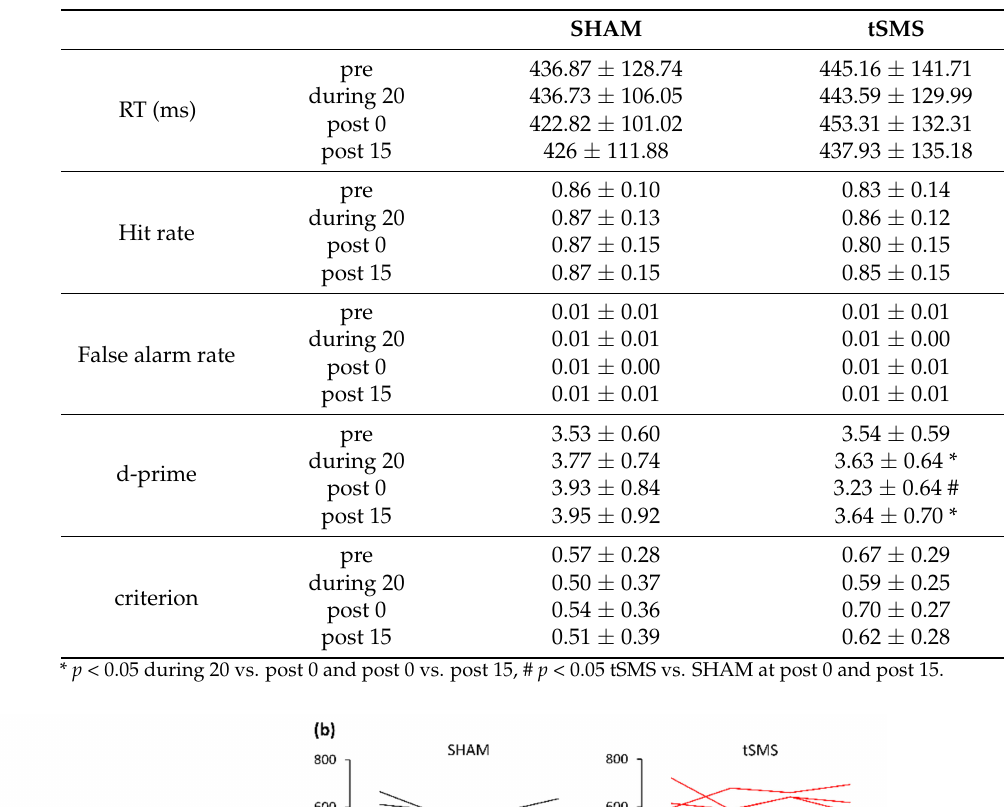
Table 1. Reaction time (RT), hit rate, false alarm rate, d-prime, and criterion (mean ± SD).